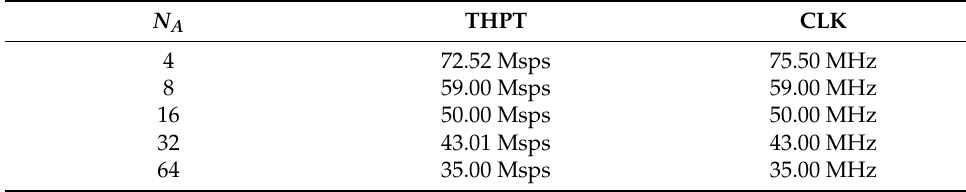
Table 5. Processing speed of the